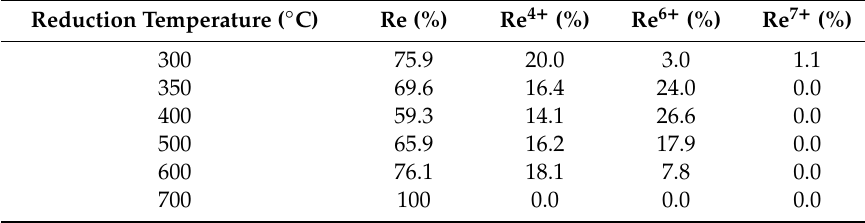
Table 3. The percent of rhenium atom in each valence state of the reduction products of